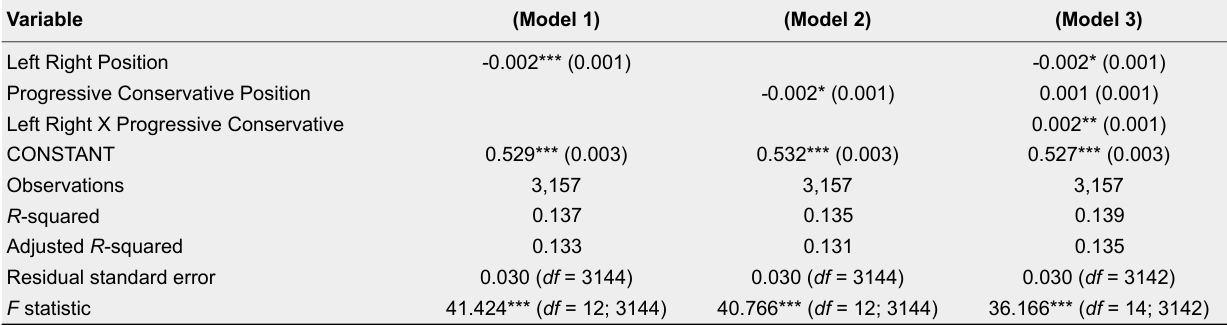
OLS Model of Level of Stop Word Use on Speaker Ideology